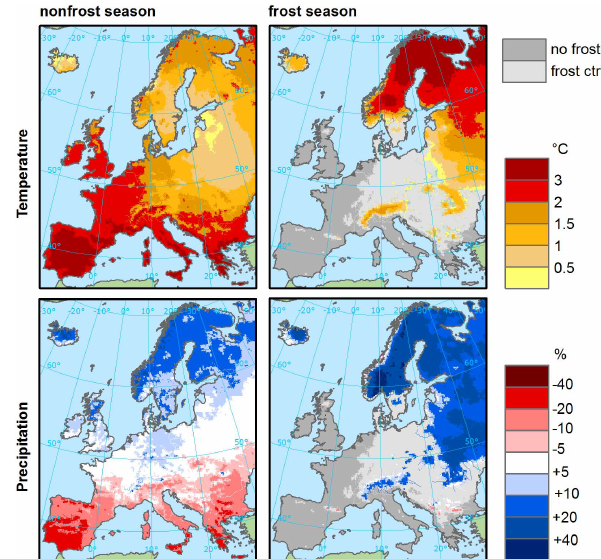
Fig. 4. Ensemble-averaged changes in average temperature (top row) and precipitation (bottom row) between 2080s and control pe- riod for nonfrost (left column) and frost (right column) seasons. The change at each location reflects the average change over the upstream area contributing flow to that location. In the frost sea- son panels, areas shaded in light gray represent regions with a frost season in the control climate and without a frost season in the ensemble-average scenario climate, while dark gray areas indicate regions with no frost season both in the control and scenario peri-